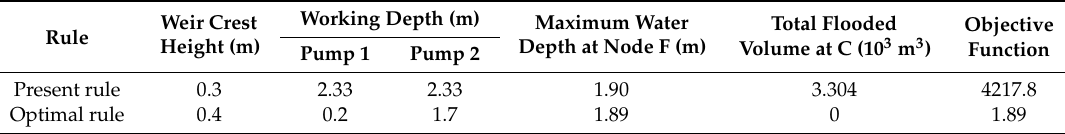
Table 4. Global optimum solution for the detention